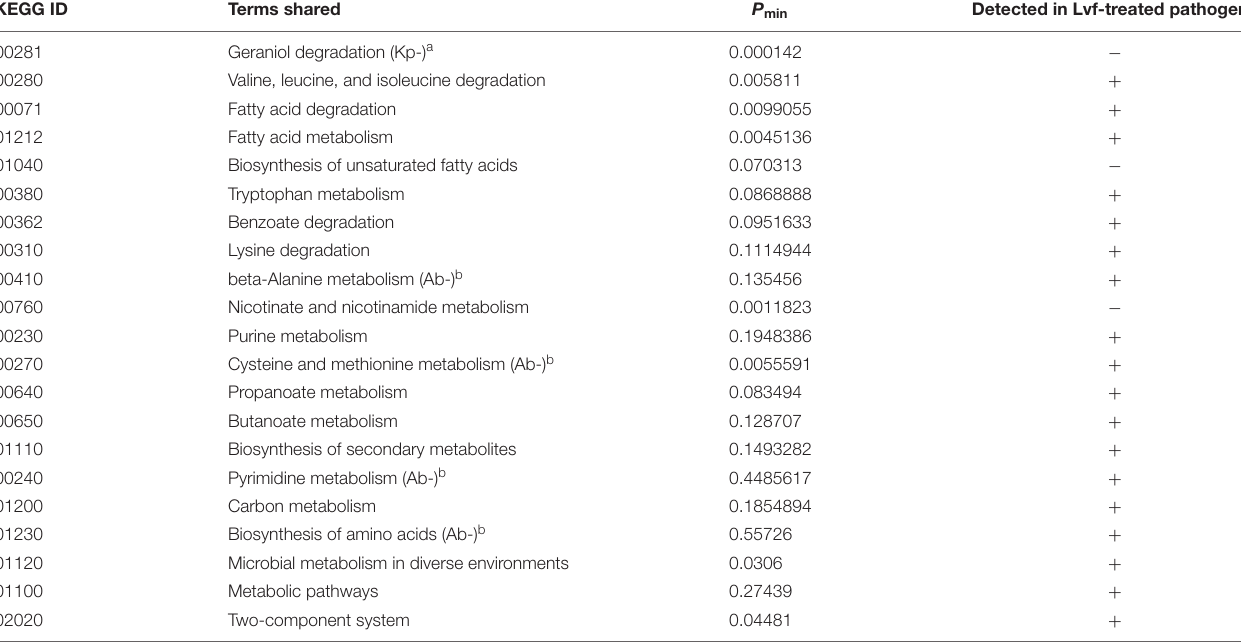
TABLE 1 | Affected KEGG pathways shared among Ta-treated pathogens after transcriptome analysis and their existence in Lvf-treated pathogens. KEGG ID Terms shared P min Detected in Lvf-treated pathogens